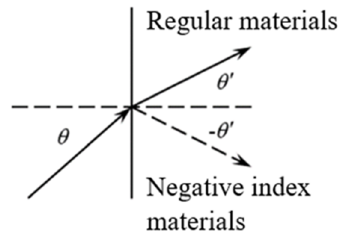
Figure 20. Negative refraction effect [63].